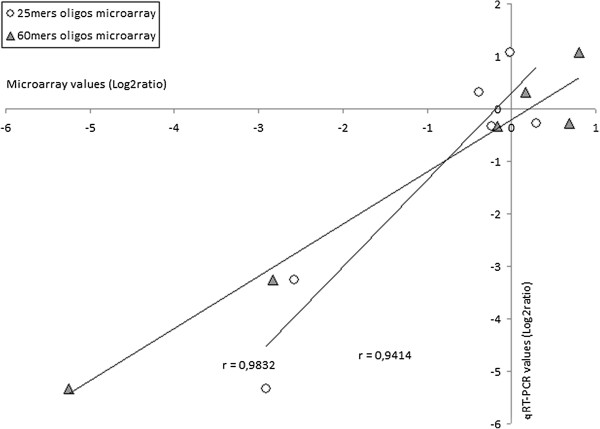
Correlations between qRT-PCR and microarray results. Statistically significant correlations were obtained for both 60-mers arrays (r = 0.9832), and 25-mers arrays (r = 0.9414).